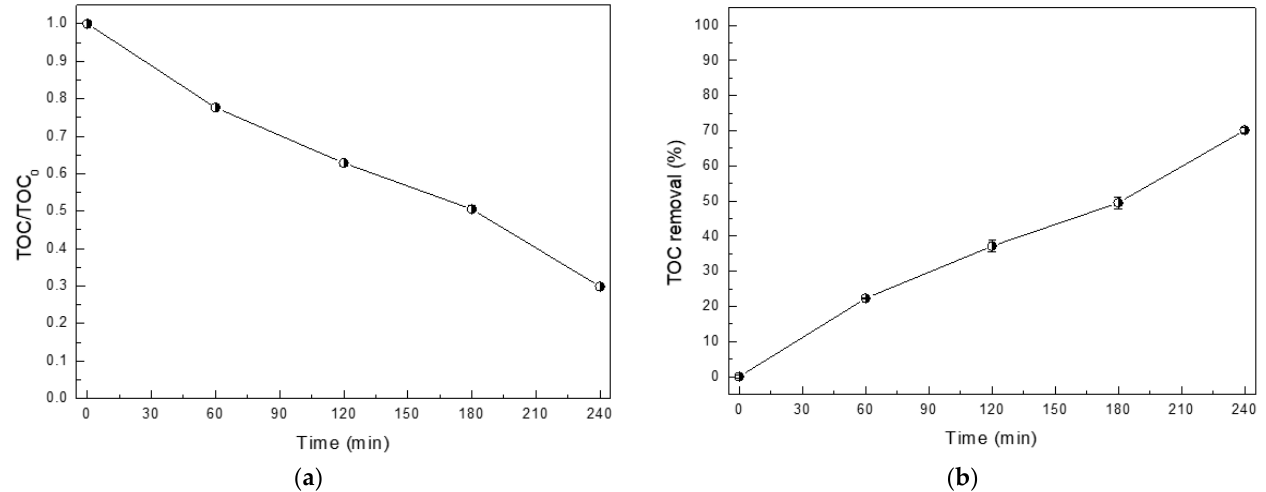
Figure 5. Total organic carbon (TOC) in RhB dye solution as a function of time ( a ) and the corresponding photocatalytic activity ( b ).